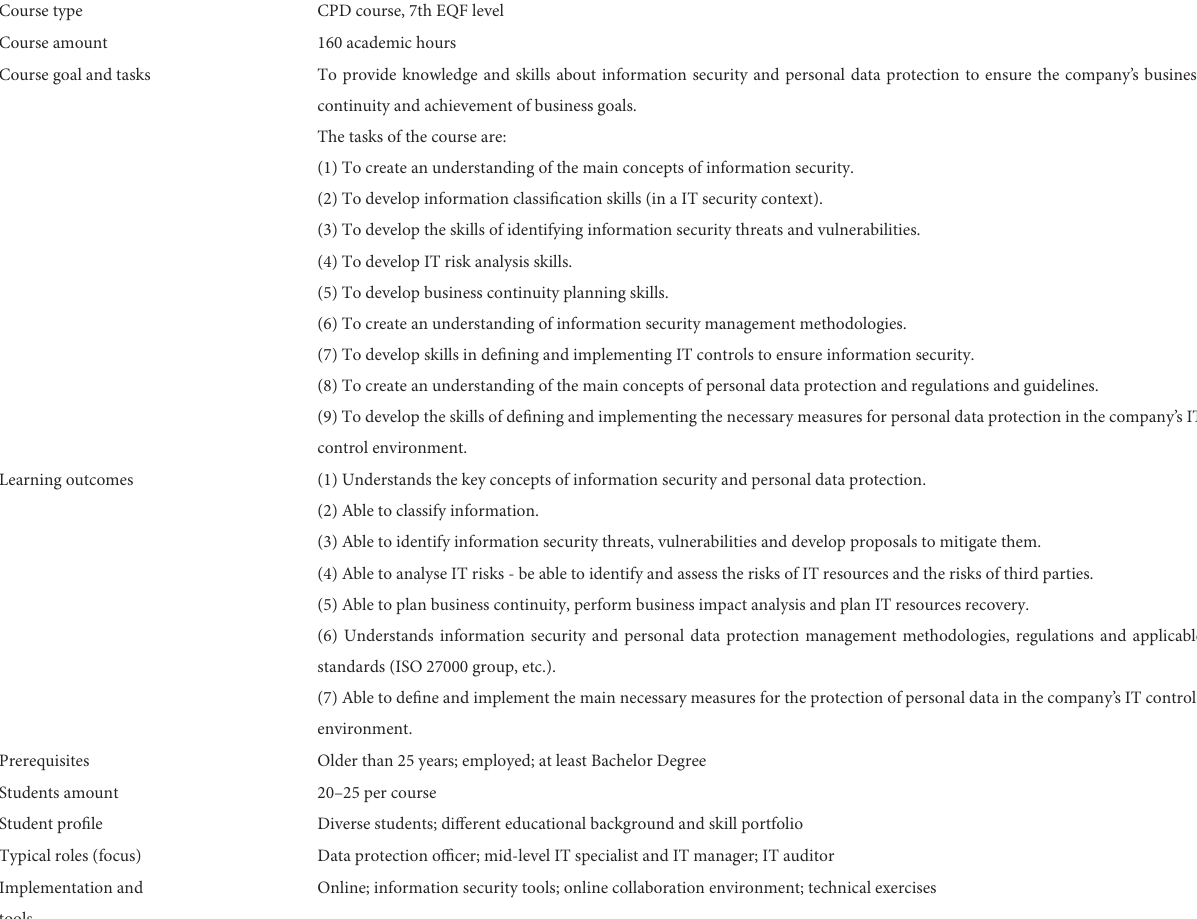
TABLE 1 CPD course characteristics